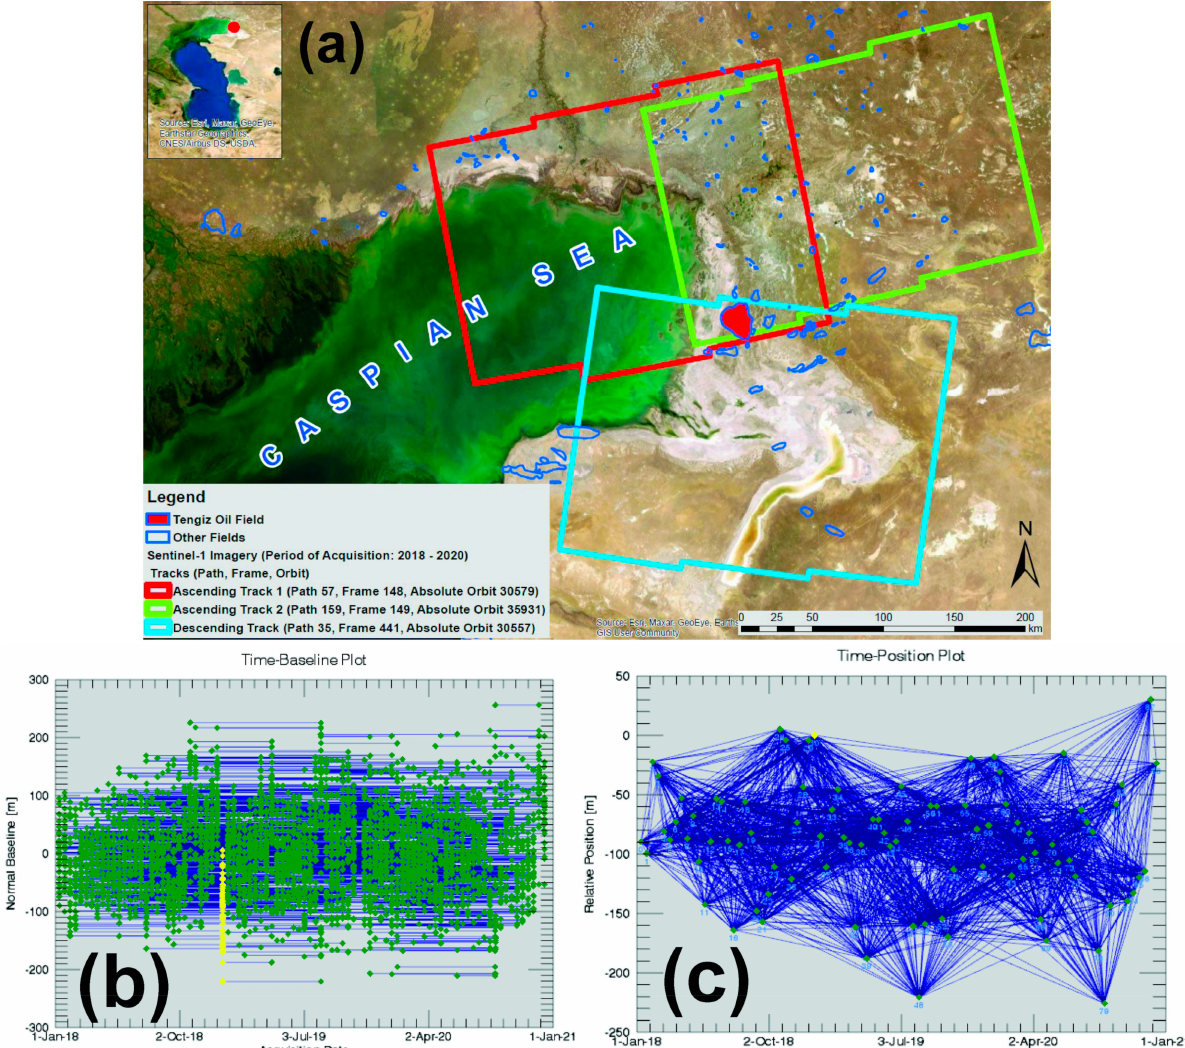
Figure 2. ( a ) Sentinel-1 imagery track numbers and acquisition details; connection graphs: ( b ) time-position plot for SBAS; ( c ) time-baseline plot for